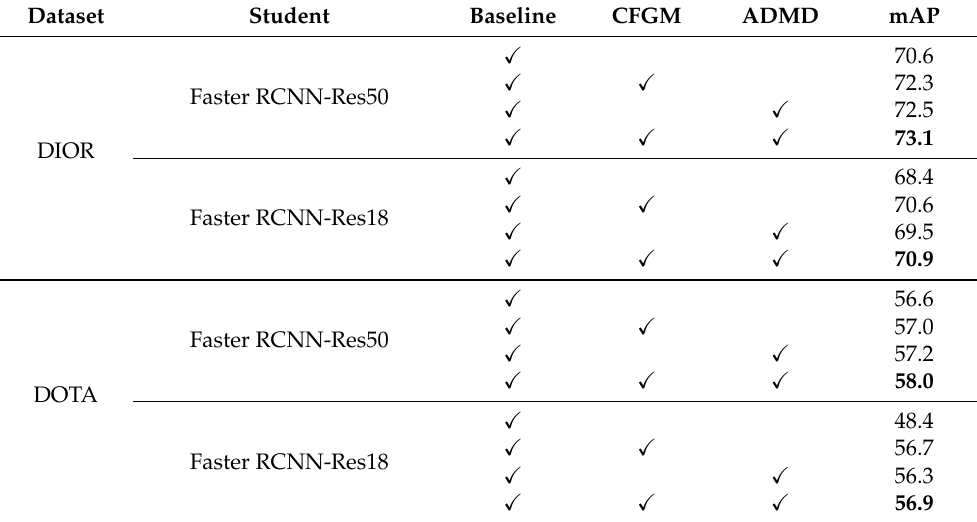
Table 2. Comparisons of the impact of the CFGM and the ADMD. The best results are marked by bold